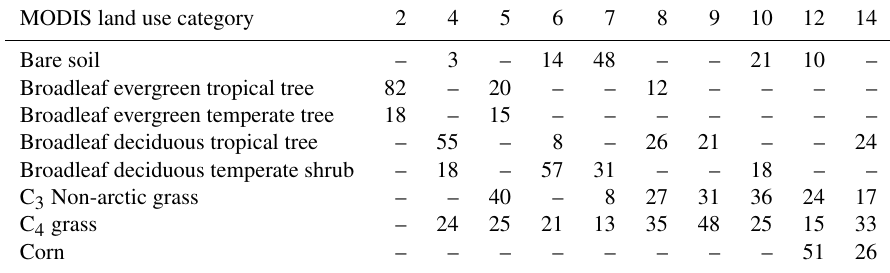
Table 2. Percentage of plant functional types assigned to MODIS land use categories in the updated CLM-AF. MODIS land use category